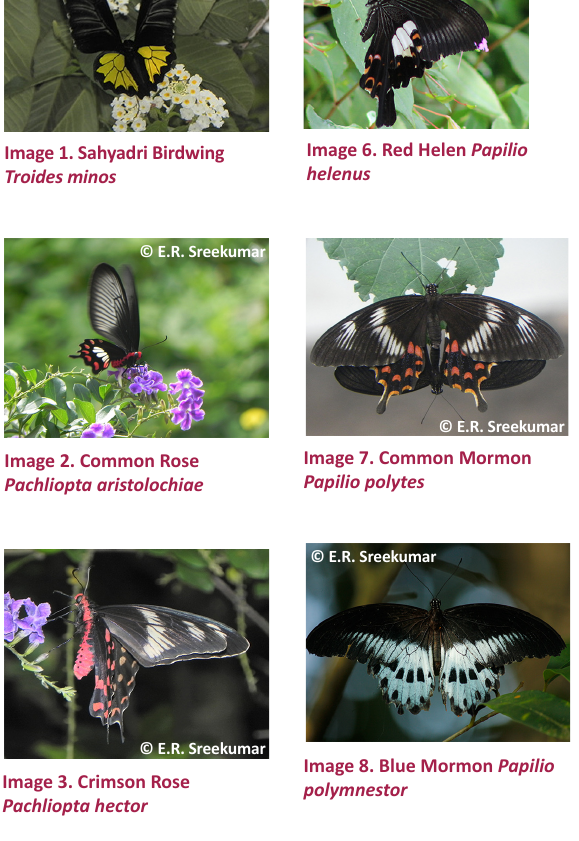
Image 8. Blue Mormon Papilio polymnestor